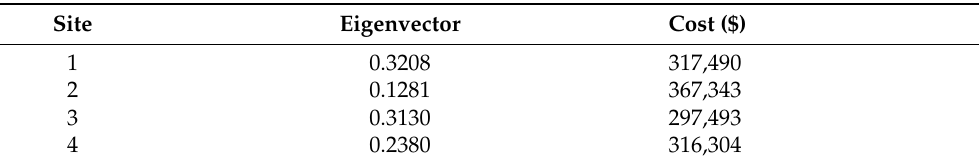
Table 5. The relative ranking and the annual operating cost of each terminal in consideration obtained using the mixed-integer programming